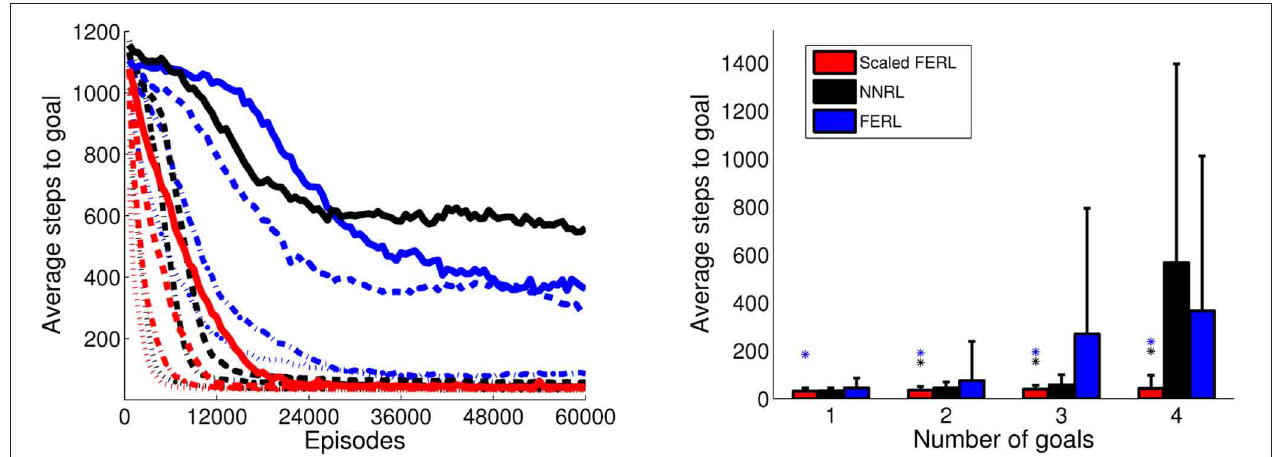
FIGURE 7 | The average number of time steps to goal for the whole learning process (left panel) and in the final 100 episodes (right panel), for the four experiments with 1, 2, 3, and 4 goal areas. The average values were computed over every 100 episodes and 10 simulation runs in each experiment. In the left panel, the line type indicates the